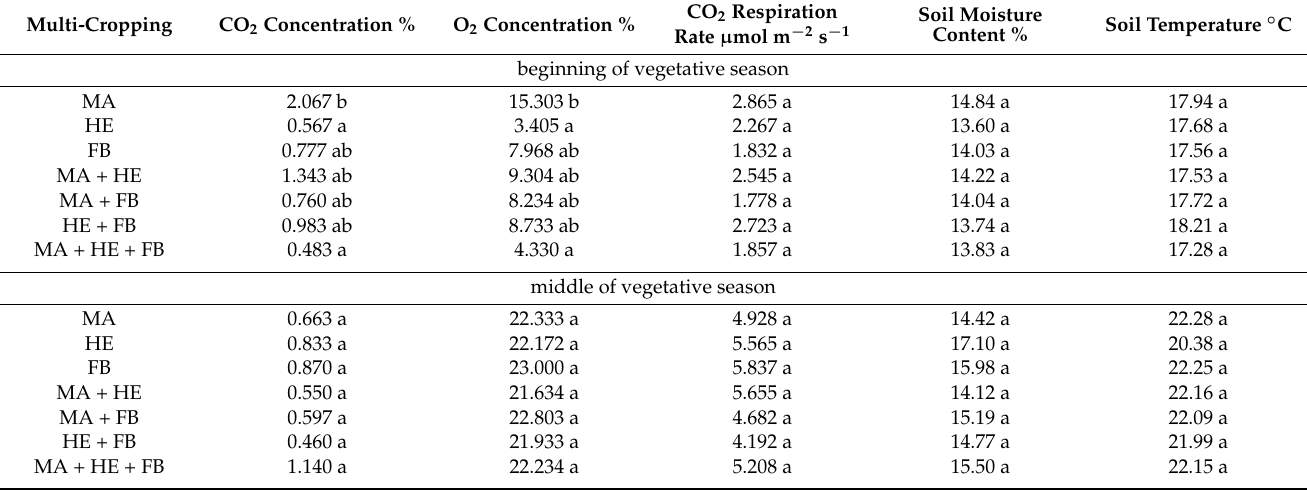
Table 6. Impact of multi-cropping on soil gas concentrations, respiration and soil thermo-hydraulic conditions,